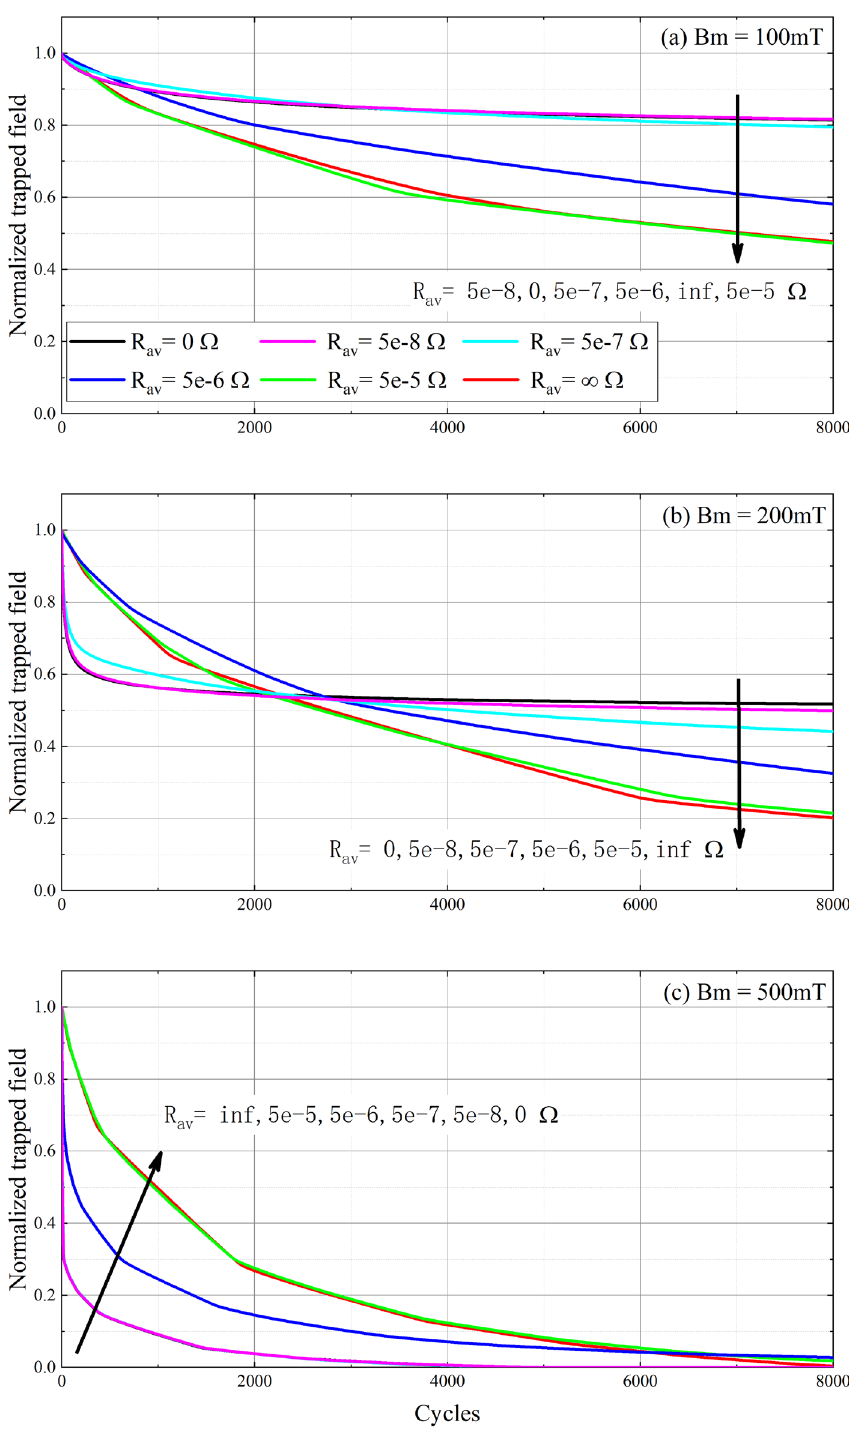
Figure 4. Normalized trapped field of three kinds of stack with a series of cross-field amplitudes at frequency 2400Hz . ( a ) B m = 100 mT, ( b ) B m = 200 mT, and ( c ) B m = 500 mT. The black solid line is the fully coupled stack, the red solid line is the uncoupled stack, and the other color dash lines are the partially coupled stack with various average